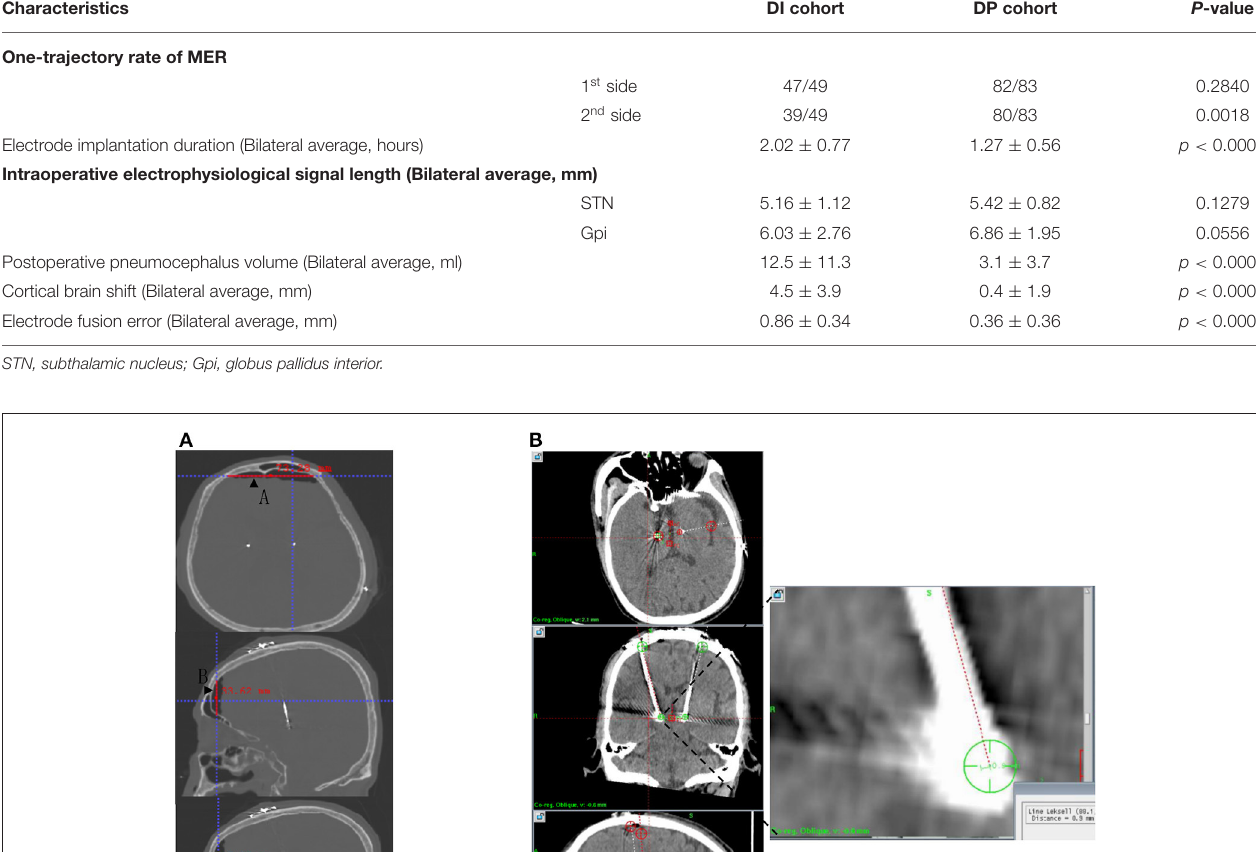
TABLE 2 | Brain shift-related parameters between two cohorts of 132 patients. Characteristics